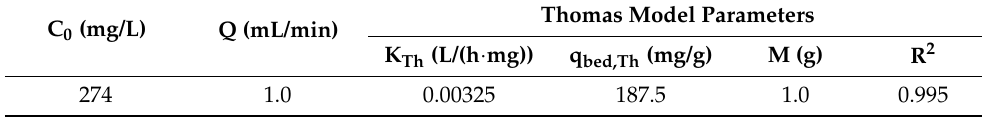
Figure 8. Dynamic adsorption curve of CPCA on PS − DEA − 5. Table 6. Thomas model fitting parameters.